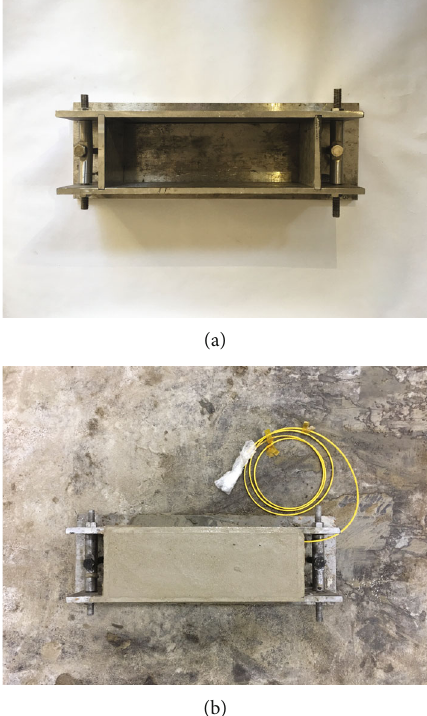
Figure 4: Preparation of seepage specimens: (a) seepage specimen mould and (b) seepage specimen.